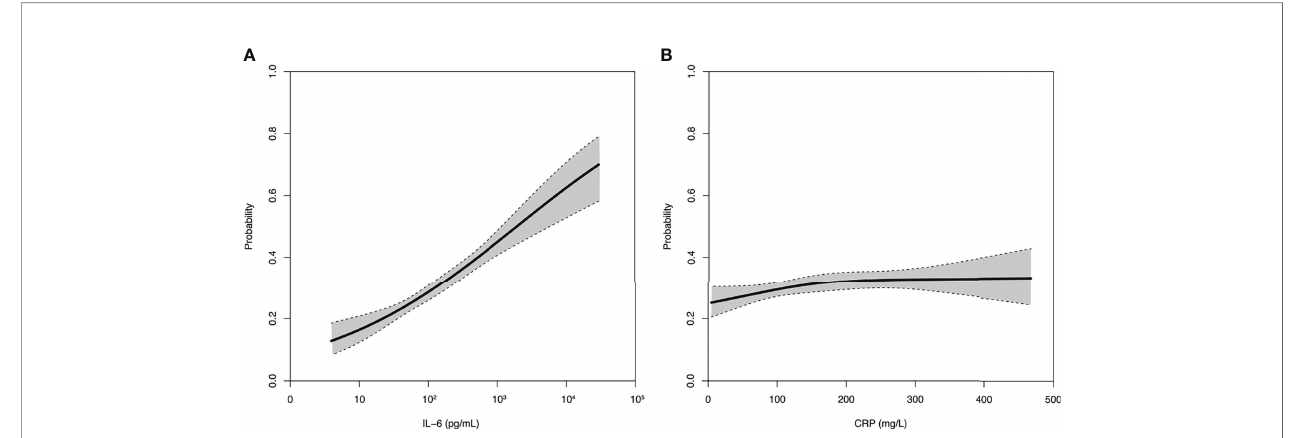
FIGURE 2 | Relation between IL-6 (A) or CRP (B) and day-90 mortality. Spline curves of the probability of day-90 mortality and associated 95% con fi dence interval according to the baseline concentration of IL-6 or CRP.